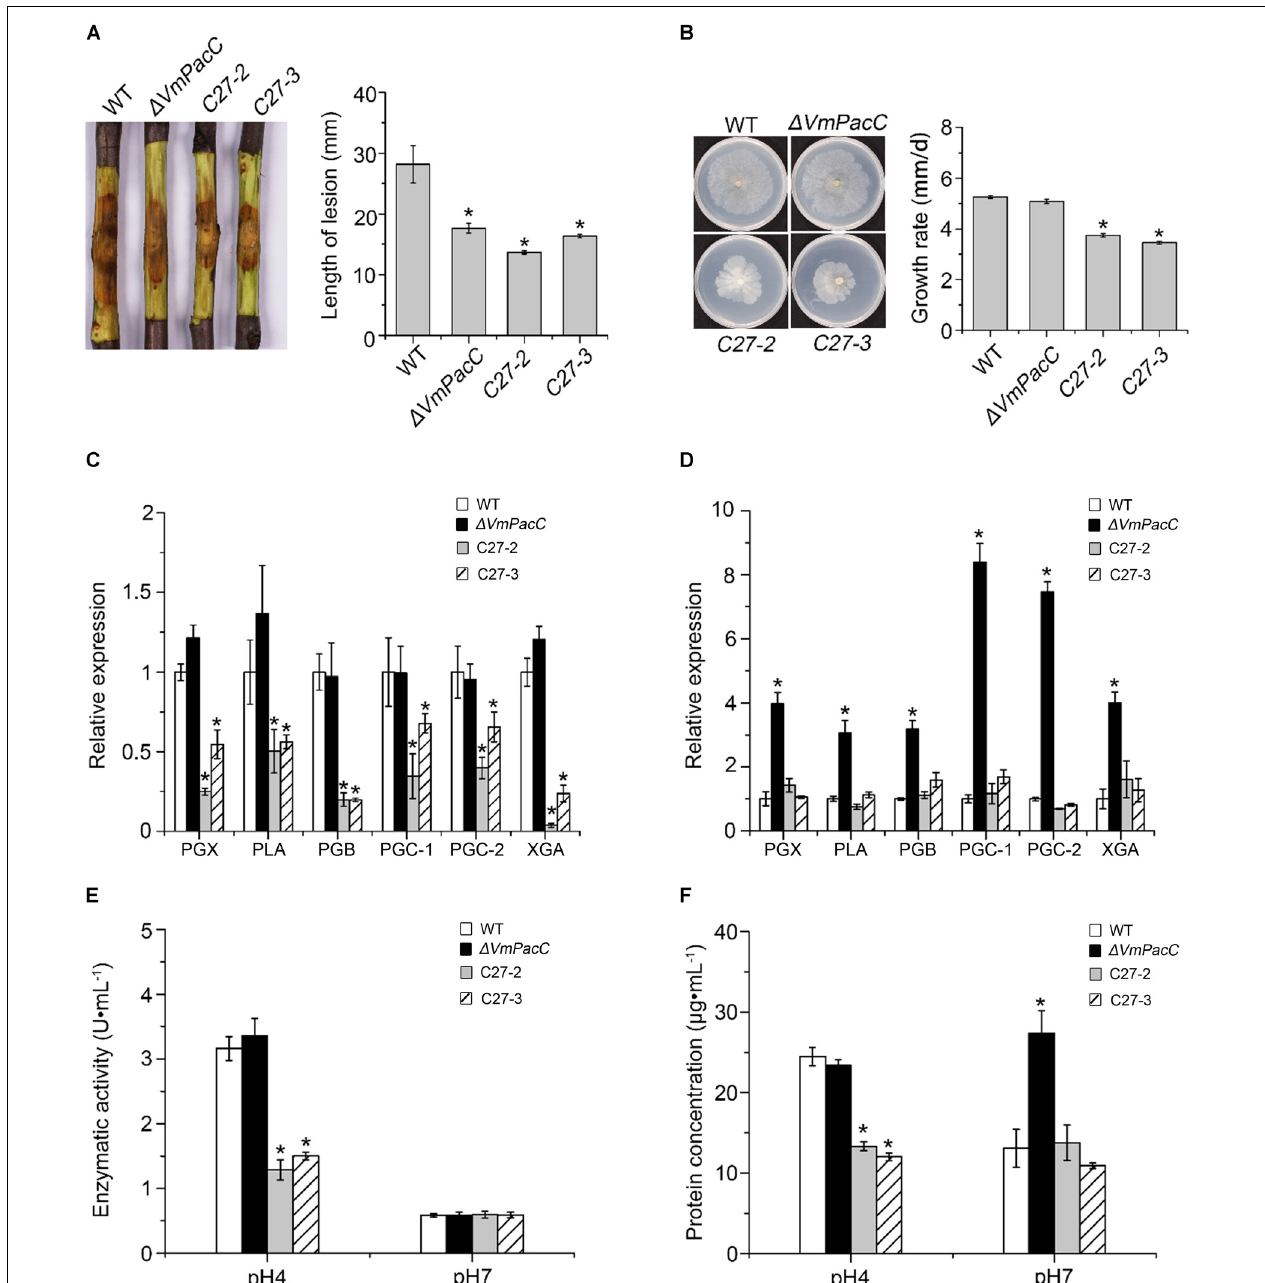
FIGURE 6 | Negative regulation of pectinase production by VmPacC dominant activated mutants C27-2 and C27-3. (A) Phenotypes of twigs inoculated with wild-type, VmPacC deletion mutant, and activated mutants C27-2 and C27-3; length of lesions was measured at 9 days post-inoculation. (B) Mycelial growth on SM supplemented with pectin for 6 days. Expression levels of pectinase genes in wild-type, deletion mutant, and activated mutant strains cultured in SM medium supplemented with pectin at pH 4 (C) and pH 7 (D) determined using qRT-PCR. (E) Pectinase activity of different strains cultured in MS supplemented pectin for 12 h. (F) Assays for protein concentration of wild-type, deletion mutant, and activated mutant strains in 1% pectin inducing medium after culture for 12 h. Bars marked by asterisks in each group differ significantly from wild-type (LSD, P < 0.05). Error bars represent standard deviations from three